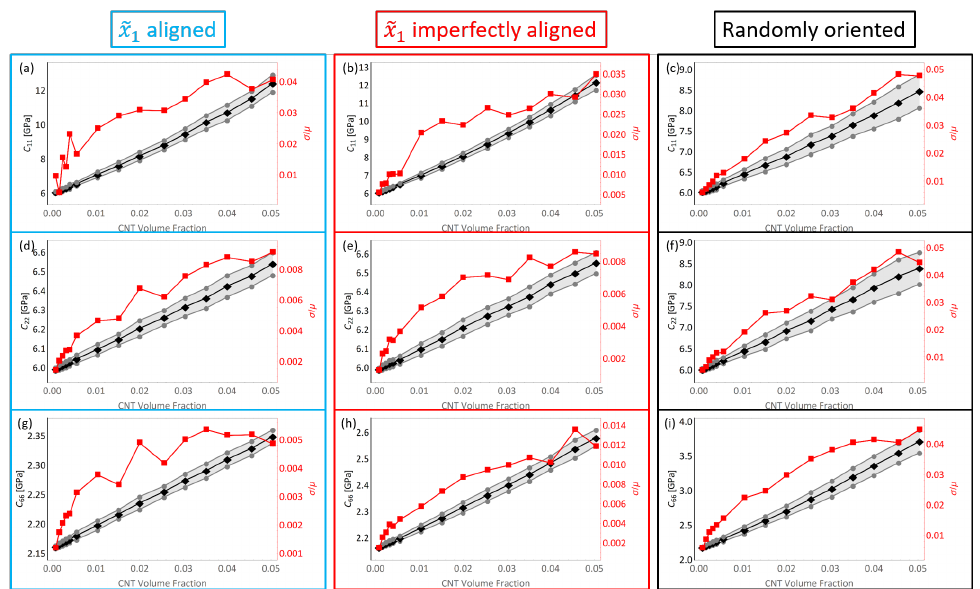
Figure 7. The mean, mean ± standard deviation and coefficient of variation depicted in black, grey and red, respectively, for C 11 ( a – c ), C 22 ( d – f ) and C 66 ( g – i ) for straight ˜ x 1 aligned CNTs, straight ˜ x 1 imperfectly aligned ( ± 15 ◦ ) CNTs and straight randomly oriented